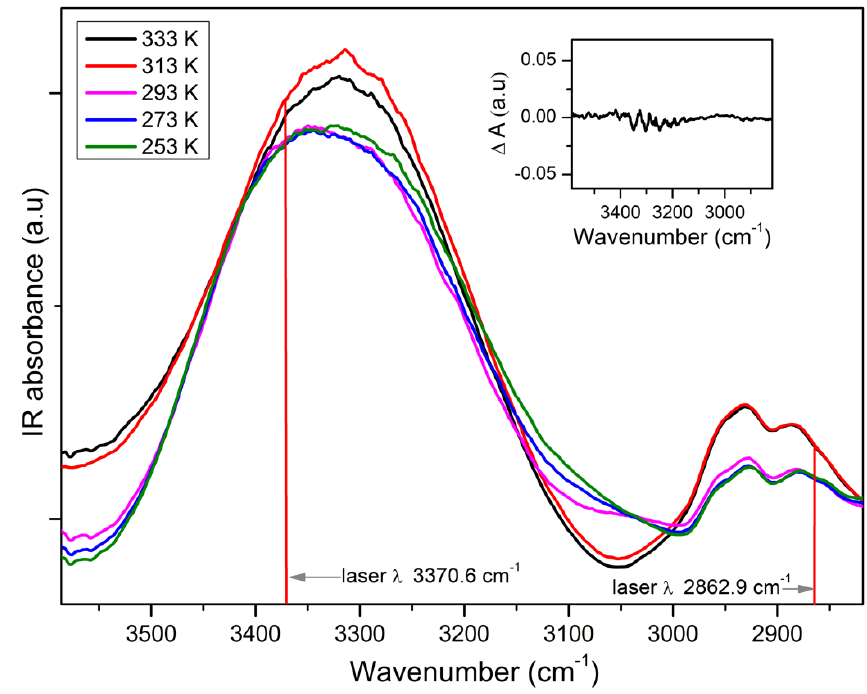
Figure 5. Characteristic IR-absorption bands of glycerol as measured with a Fourier-IR spectrometer at varying temperatures as indicated. The wavenumber of the quantum cascade laser diodes used in this study are marked. As spacer, a poly(ethylene terephthalate) (PET) foil of ~3 µ m thickness was used; this results is for an applied voltage of +/ − 120 V in an electric field strength ~+/ − 0.4 MV/cm. The inset shows the difference IR spectrum between a sample measured with and without external electric field at 333 K.